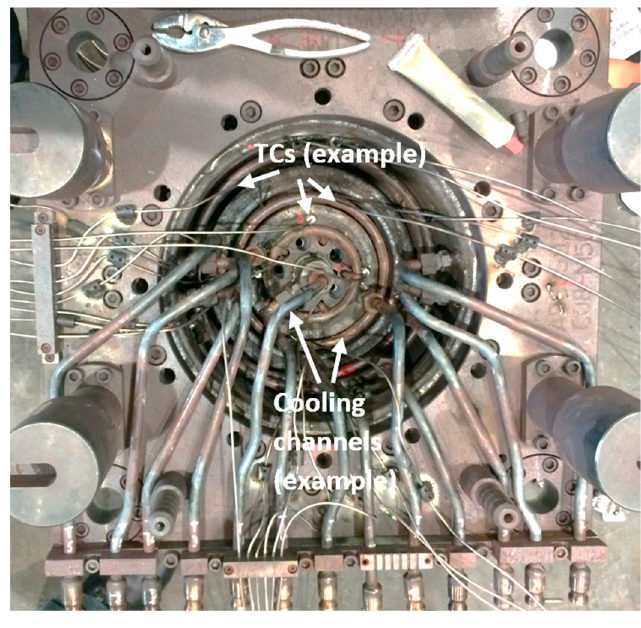
( b ) Example of TC installation at the top die. Figure 7. Locations of the cooling channels and TCs ( a ), and the photo showing the TC installation at the top die ( b ).